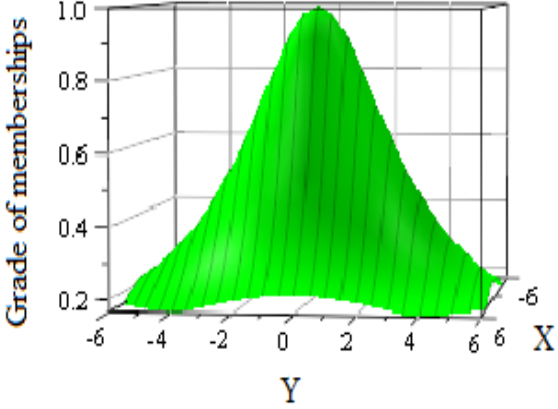
Figure 2. Graphical representation of the Fs -valued map in Example